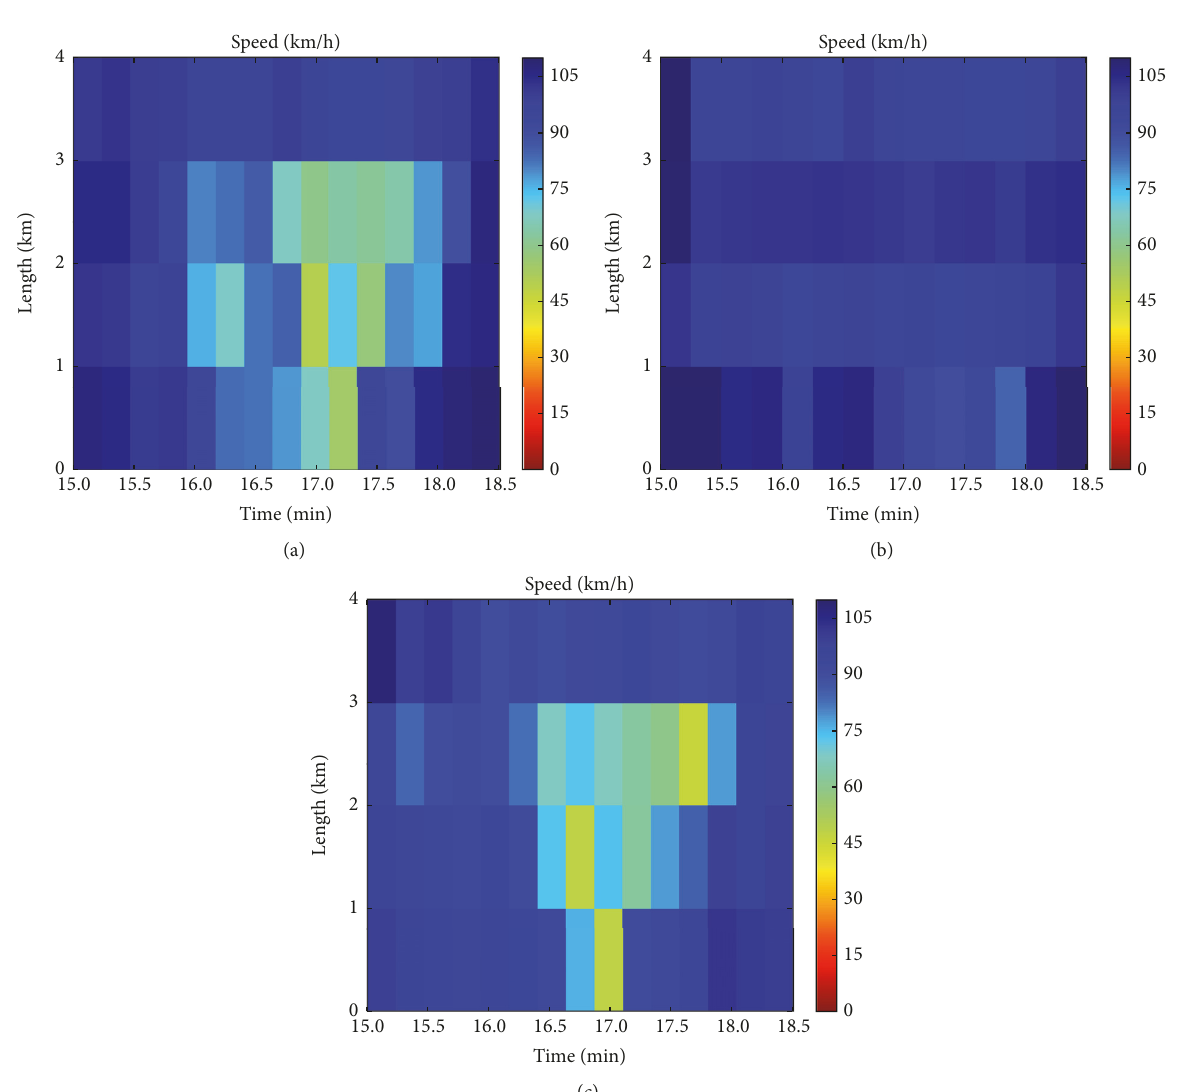
Figure3:Themeanspeedforthegivendetectormeasurements(a),theuncalibratedscenario(b),andthecalibratedscenario(c).Thedetectors are represented on 𝑦 -axis and the time instants are represented on 𝑥 -axis (15min intervals). The mean speed is ranging from 0km/h (red) to 110km/h